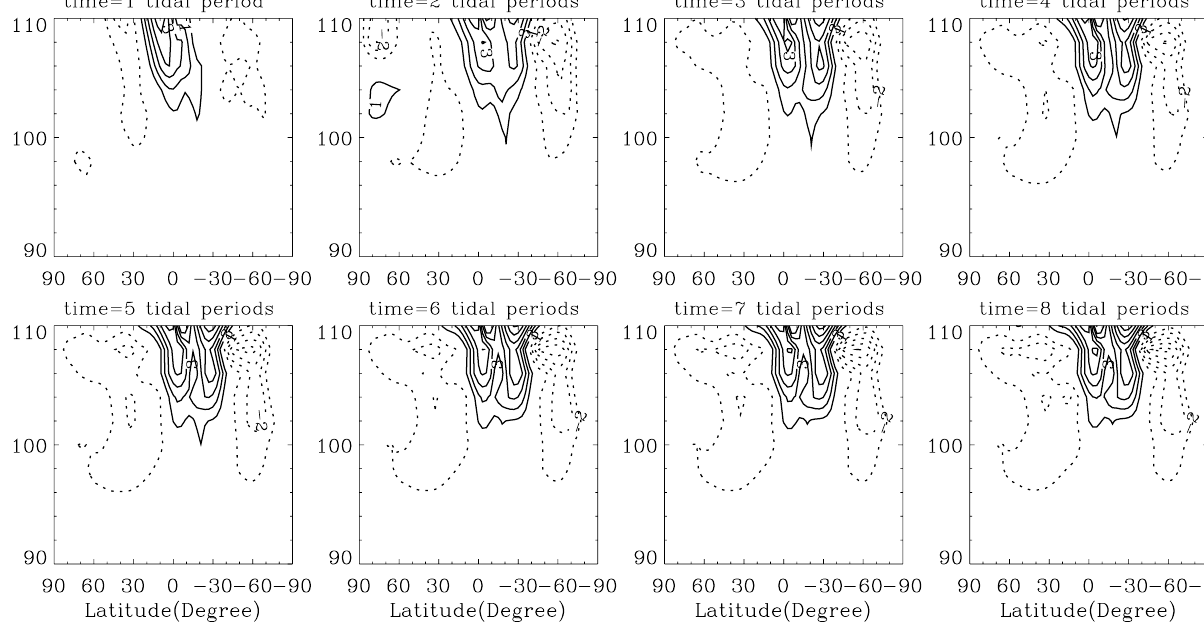
Fig. 3. Same as Fig. 2 but for June. The intervals of the contours are 1ms − 1 . The solid and dotted curves denote the positive and negative values, respectively.